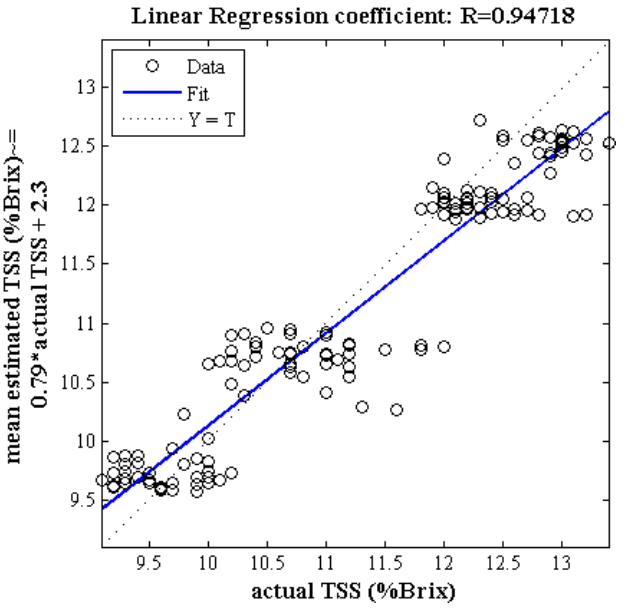
Figure 4. Box diagram of five criteria for evaluating ANN-BBO performance in estimating the starch content of Fuji apple on spectral data of 800 to 900 nm in 100 iterations. ( a ) coe ffi cients of regression and determination, ( b ) error criteria.